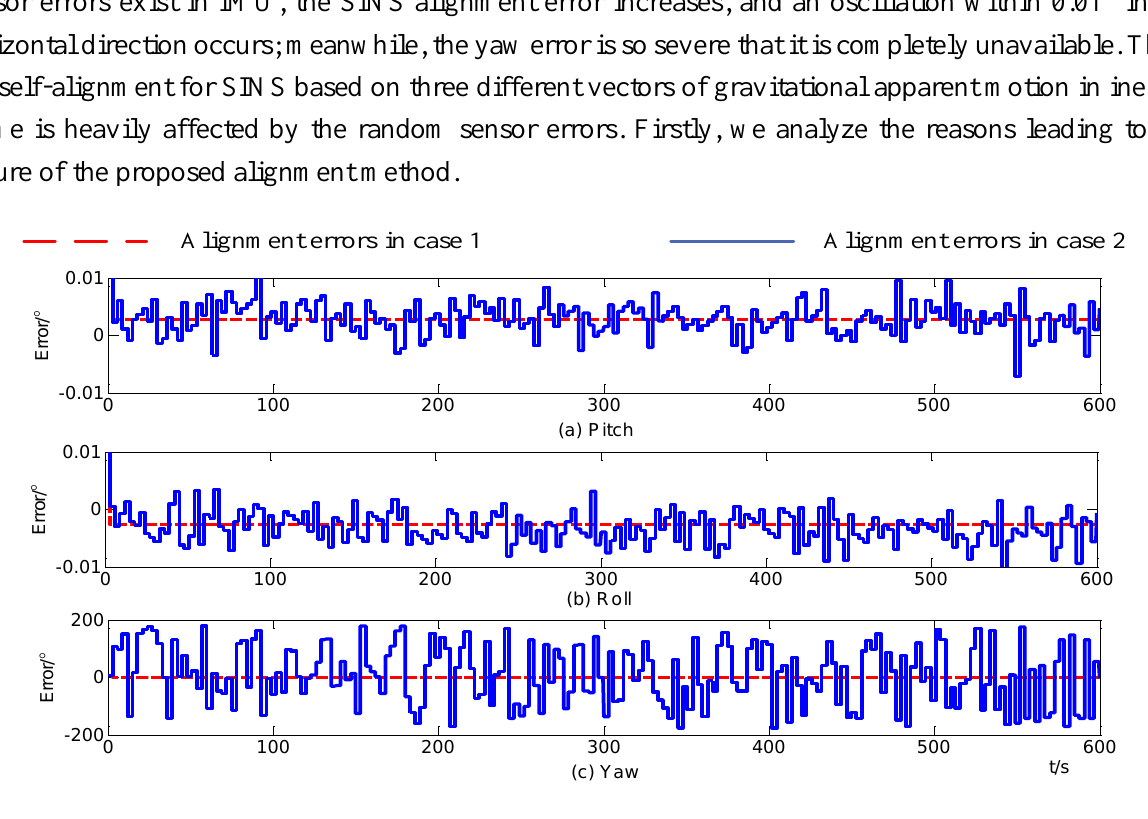
Figure 5. Curves of alignment